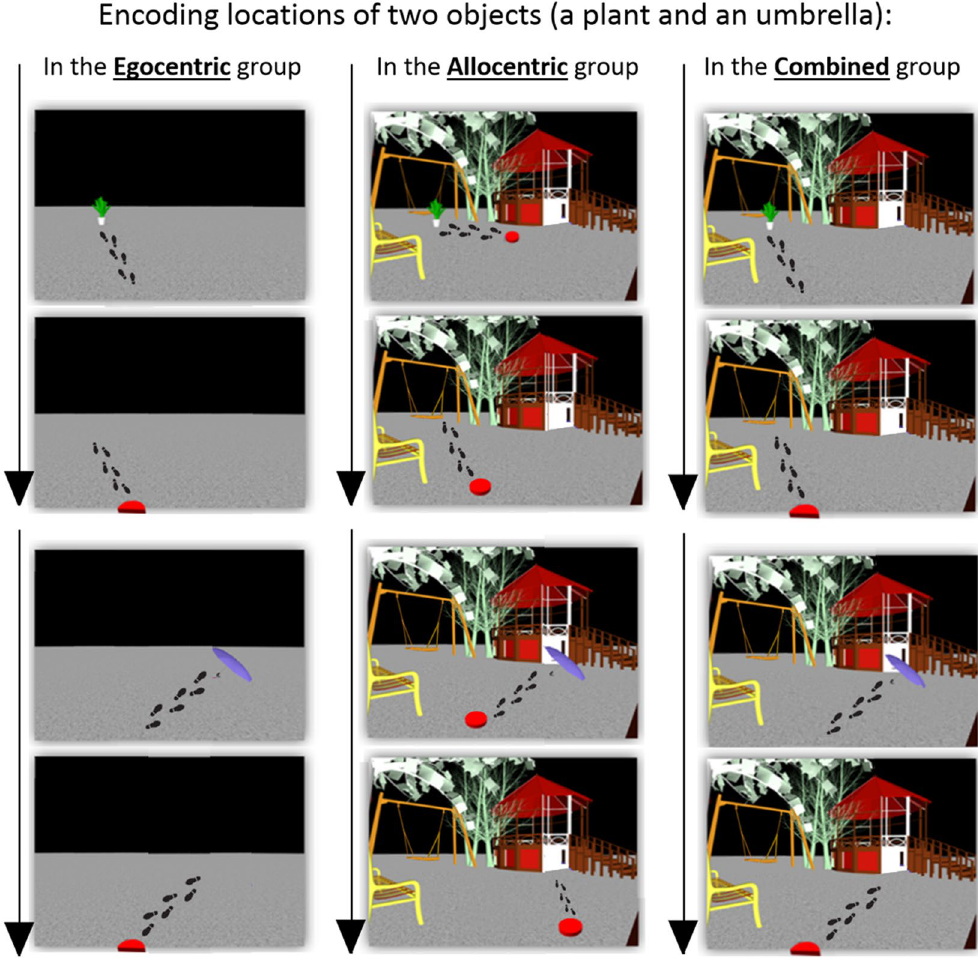
Figure 2. The three spatial-cue conditions. Participants were assigned to either the egocentric, the allocentric, or the combined condition. The footsteps (not shown in the task) represent exemplary paths that participants walked in each condition, to encode the locations of two objects (a plant and an umbrella). Left: The egocentric condition contained no spatial landmarks, and the distance and direction to each object were encoded from a fixed viewpoint (the red semicircle). On every trial, participants started at the red semicircle, walked to the object, and made a perceptual judgment. The object then disappeared, and participants walked back to the red semicircle. Next, a new object was shown, and the procedure was repeated. See video 1 for further details. Middle: In the allocentric condition , no fixed viewpoint was used as different viewpoints were used. On every trial, participants started at a temporary red circle, walked to the object, and made a perceptual judgment. The object then disappeared, and participants walked to another red circle (which appeared in a different location than before). However, participants could code the locations of the objects relative to environmental landmarks. Next, a new object was shown, and the procedure was repeated. See video 2 for further details. Right: In the combined condition (right), the locations of the objects could be coded relative to the fixed viewpoint and relative to the spatial landmarks. See video 3 for further